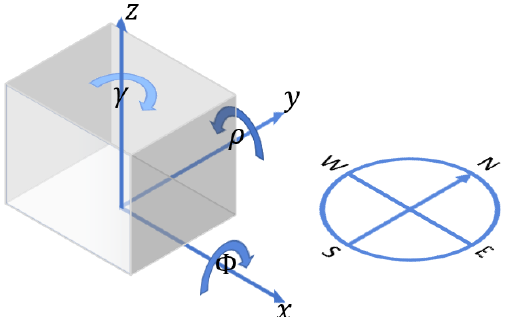
Figure 5. Coordinate system of the lidar with the clockwise rota- tions around the axes and a compass rose. γ is the yaw angle, ρ is the roll angle, and φ is the pitch angle of the